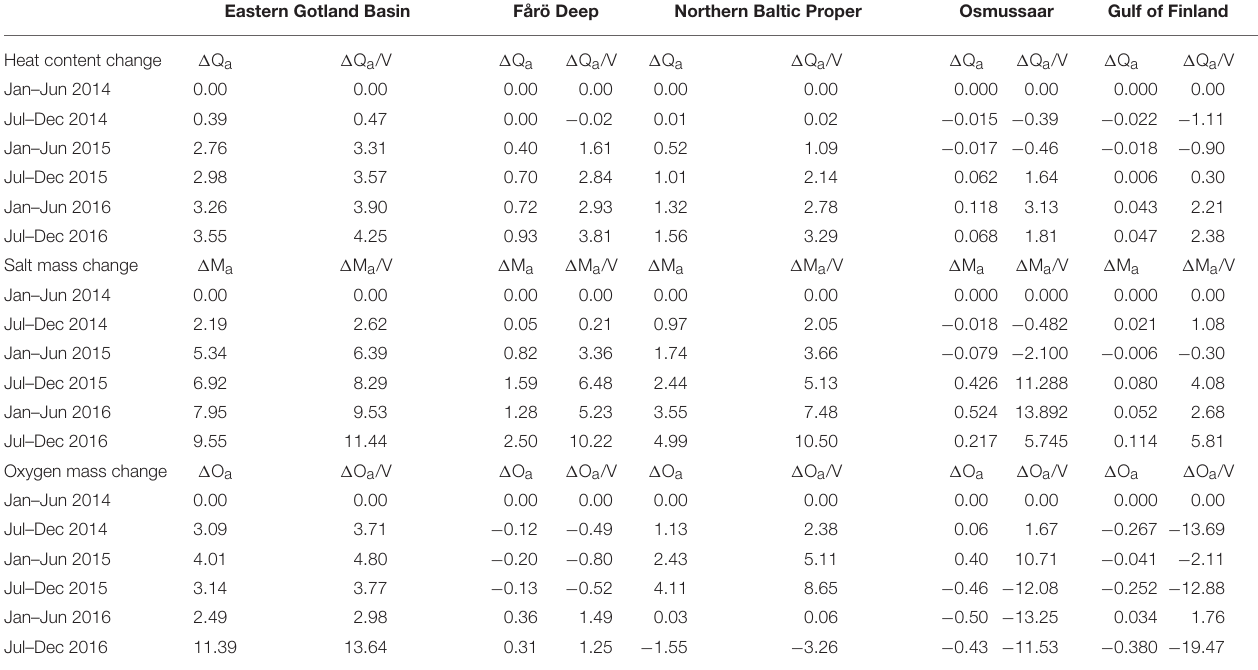
TABLE 1 | Changes in heat content ( 1 Q a , 10 18 J), heat content per volume ( 1 Q a /V, 10 15 J km − 3 ), salt mass ( 1 M a , 10 8 t), salt mass per volume ( 1 M a /V, 10 5 t km − 3 ), oxygen content ( 1